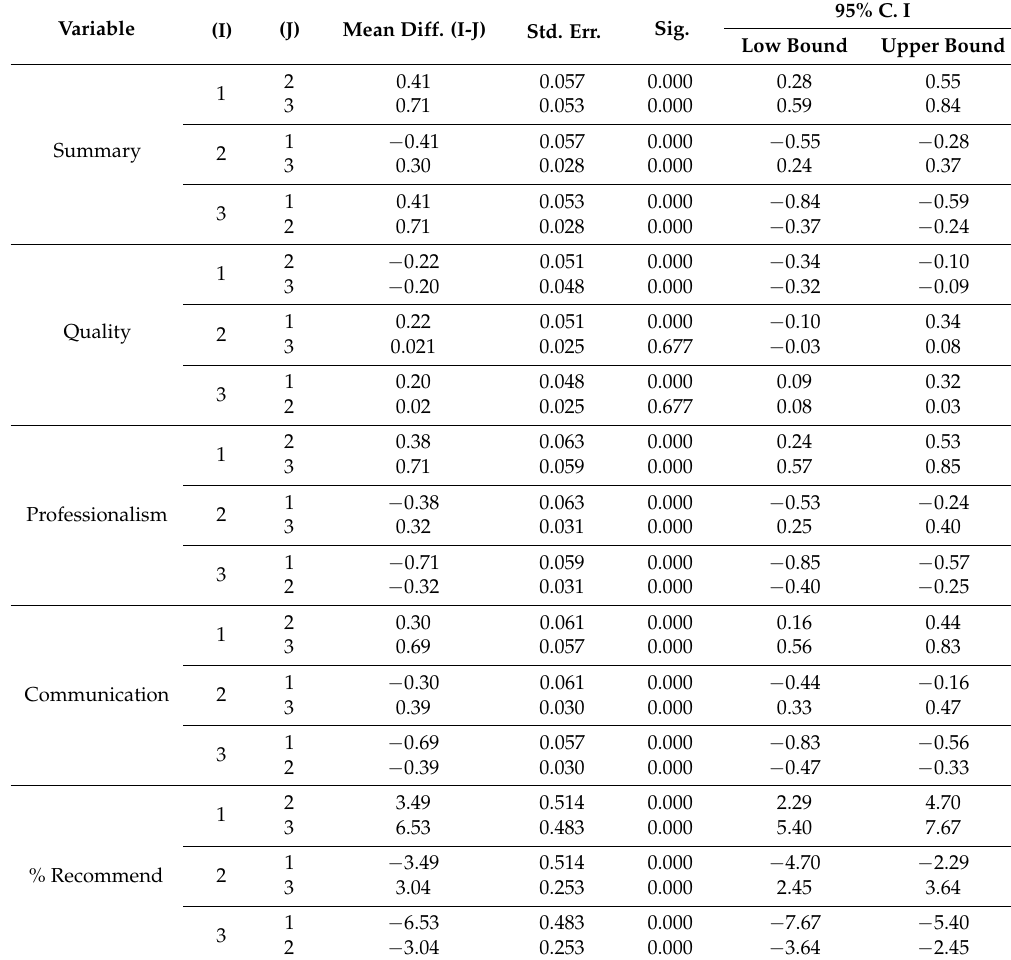
Table 7. Stepwise multiple comparisons with Tukey post hoc test (Governmental = 1, Non-Profit = 2, For-Profit = 3).